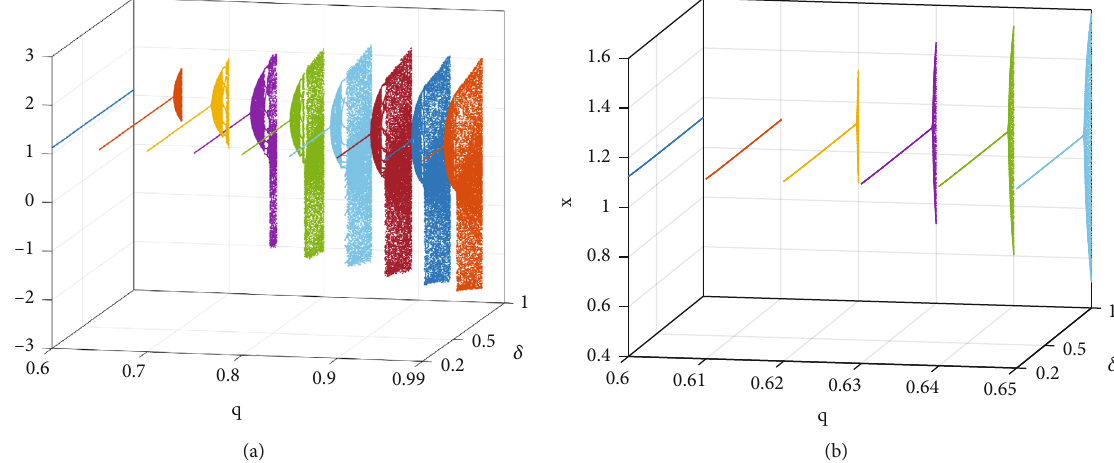
Figure 2: The bifurcation diagrams of map (10) when δ and q are varied. (a) q ∈ ½ 0 : 6, 0 : 99 (cid:2) . (b) q ∈ ½ 0 : 6, 0 : 65 (cid:2) .